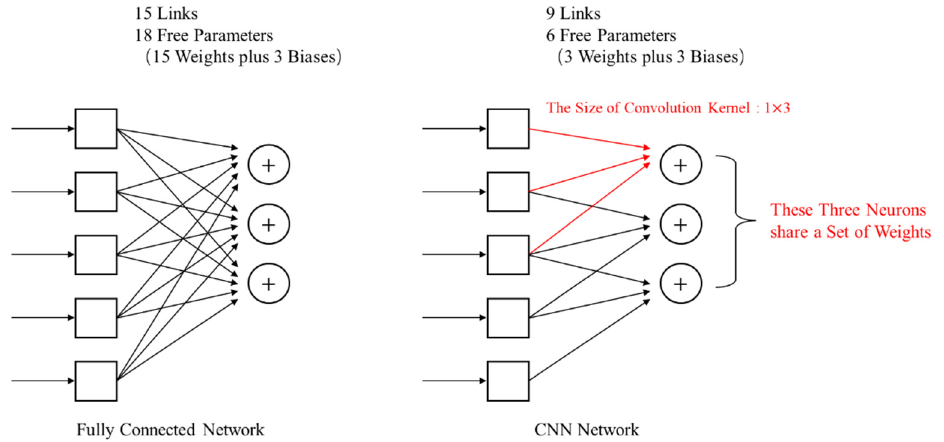
Figure 1. Structural comparison between CNN and fully connected networks (take the simple struc- ture as an example). structure as an